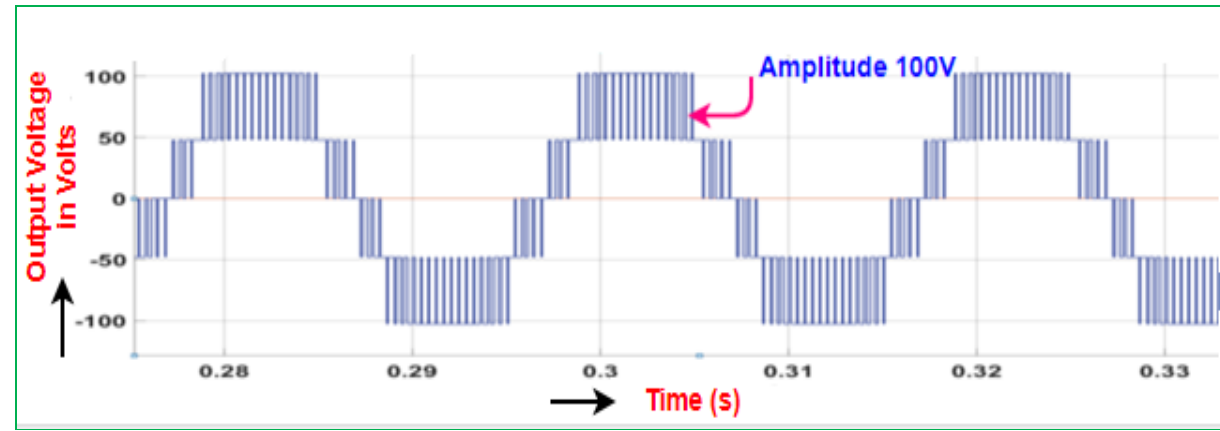
Figure 11. Output voltage of T-bridge multilevel inverter. Figure 11. Output voltage of T ‐ bridge multilevel inverter. Figure 11. Output voltage of T ‐ bridge multilevel inverter. Figure 11. Output voltage of T ‐ bridge multilevel inverter.